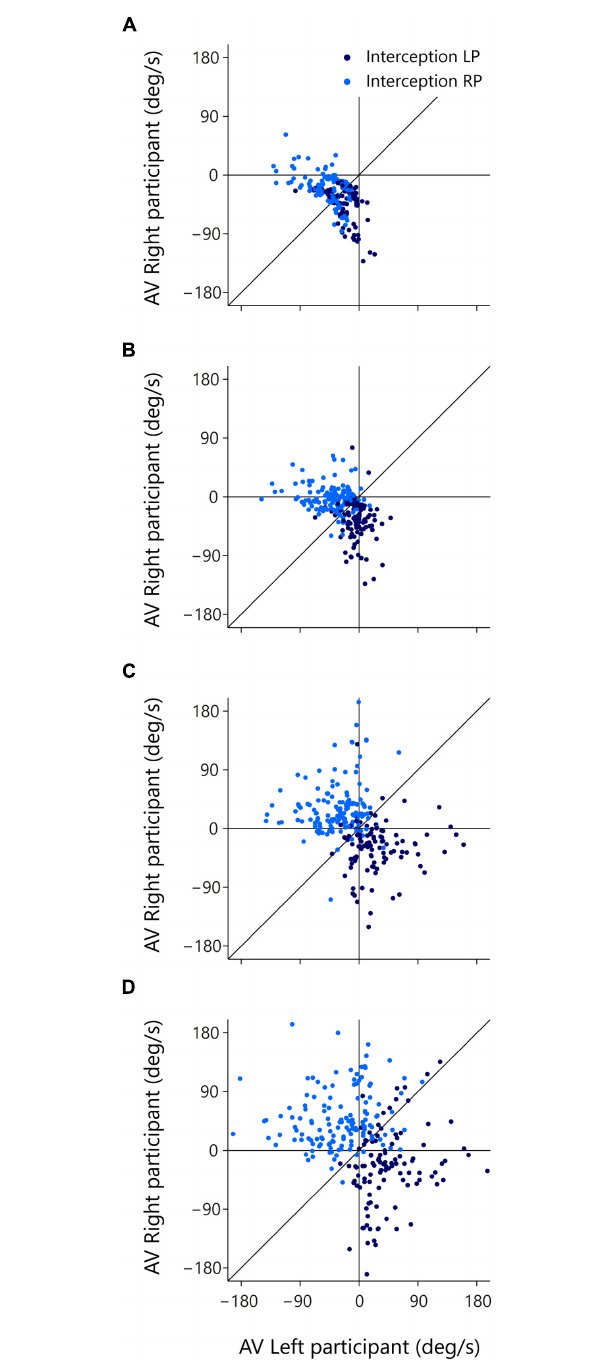
FIGURE 8 | Rate of change of β RP (AV-RP) as a function of rate of change of β LP (AV-LP) for the trials with both LP and RP initiation at different moments in time. Dark blue dots indicate LP-interception trials and light blue dots indicate RP-interception trials. The thin vertical and horizontal lines in each panel mark zero AV for the LP and RP, respectively. Movement of dots across these lines mark transitions from negative to positive AV. The thin diagonal line in each panel marks AV-LP = AV-RP. (A) At the moment the first participant initiated a movement, (B) 100 ms later, (C) 200 ms later, and (D) 300 ms